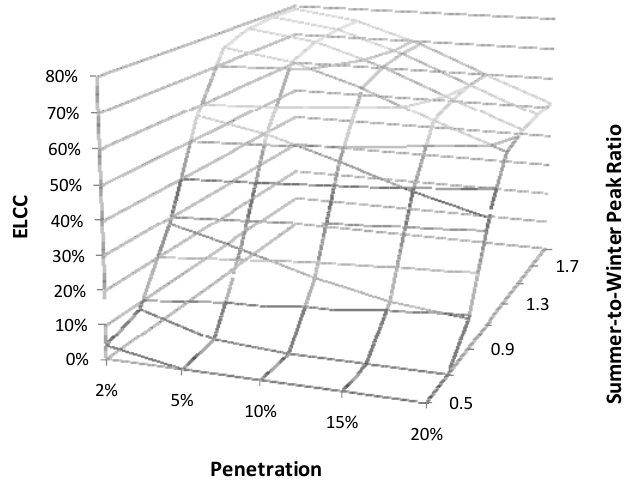
Figure 59. ELCC as a function of grid penetration and SWPR for US fixed 30  -angle south-facing PV systems (derived from